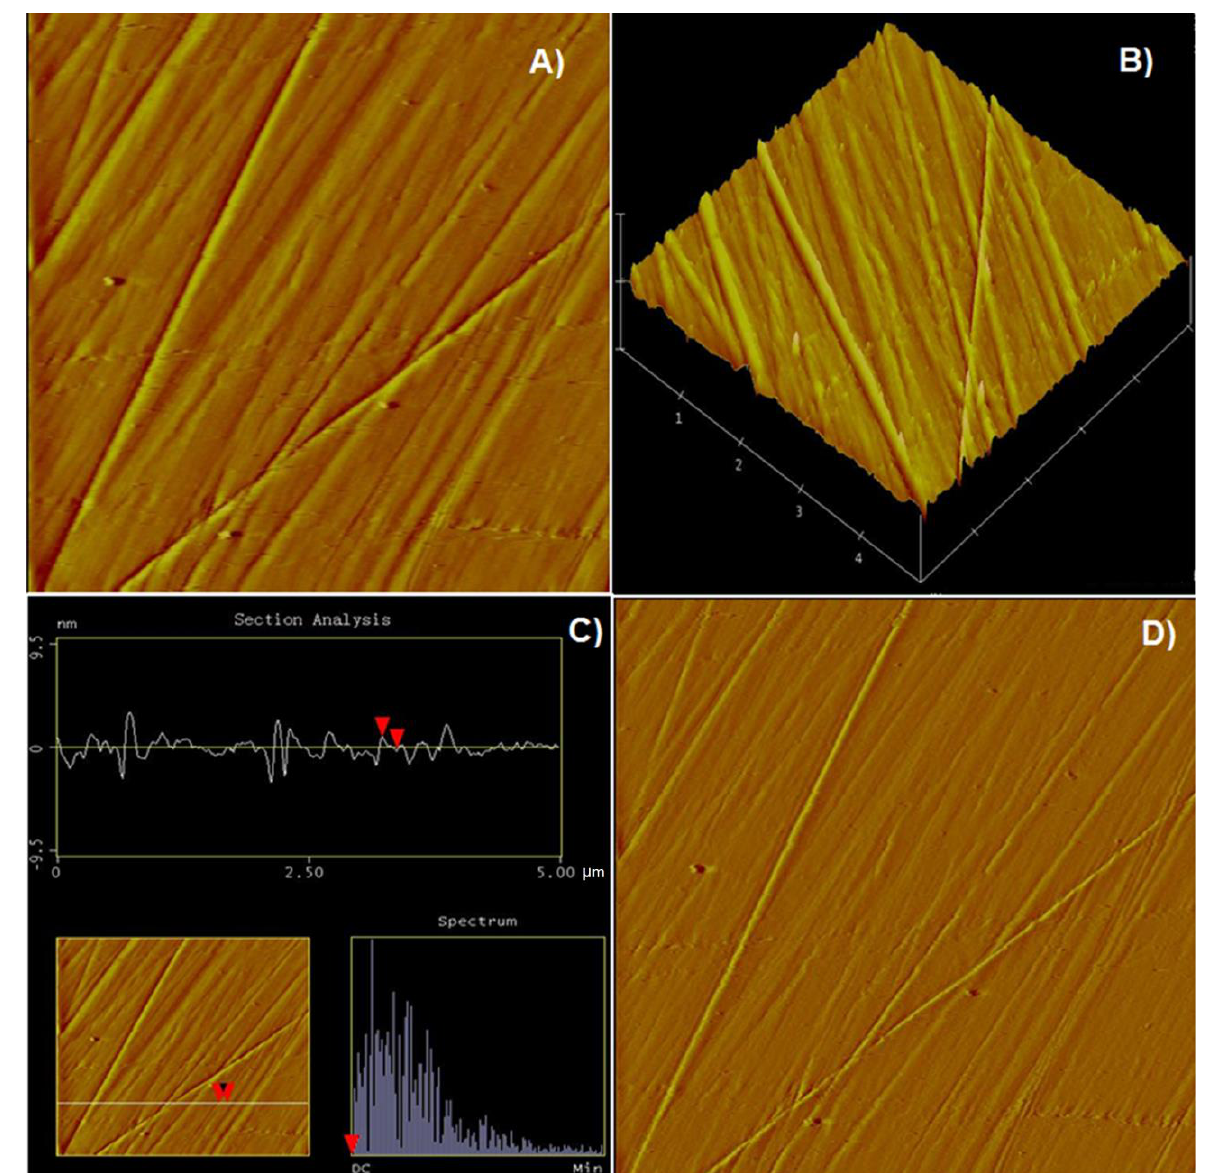
Figure 2. AFM images of a bornite surface soaked in water for 10 min. ( A ) The 5 µm × 5 µm height image with a data scale of 20 nm, ( B ) the 3D image, ( C ) the section analysis (the red arrows indicate the top and the bottom of an average asperity) and ( D ) the deflection image with a data scale of 10 nm.